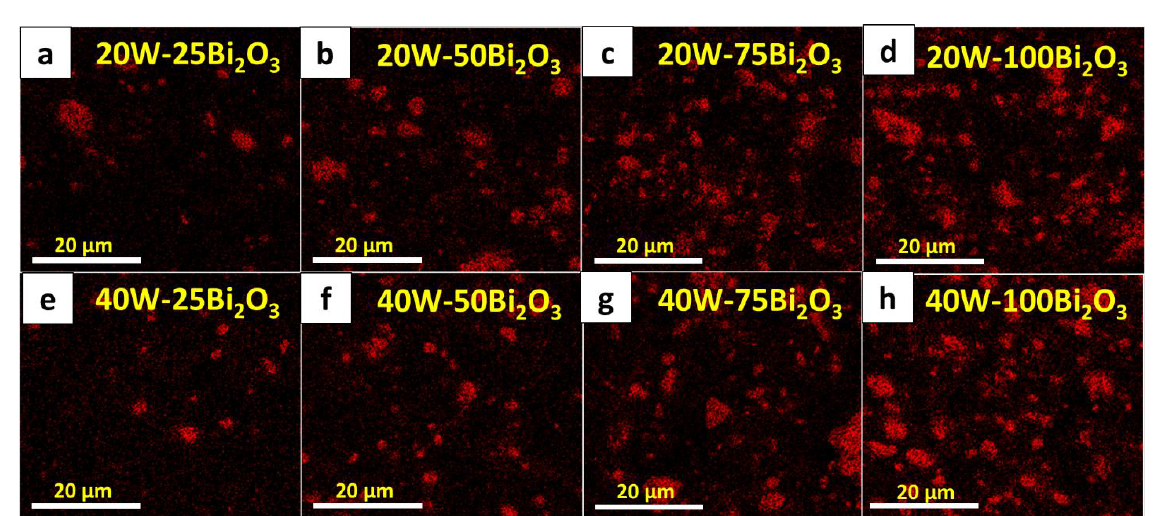
Figure 6. SEM-EDX images showing dispersion of Bi element in WPVC composites with ( a ) 20 pph wood particles and 25 pph Bi 2 O 3 , ( b ) 20 pph wood particles and 50 pph Bi 2 O 3 , ( c ) 20 pph wood particles and 75 pph Bi 2 O 3 , ( d ) 20 pph wood particles and 100 pph Bi 2 O 3 , ( e ) 40 pph wood particles and 25 pph Bi 2 O 3 , ( f ) 40 pph wood particles and 50 pph Bi 2 O 3 , ( g ) 40 pph wood particles and 75 pph Bi 2 O 3 , and ( h ) 40 pph wood particles and 100 pph Bi 2 O 3 . Red areas represent presence of Bi in composites.